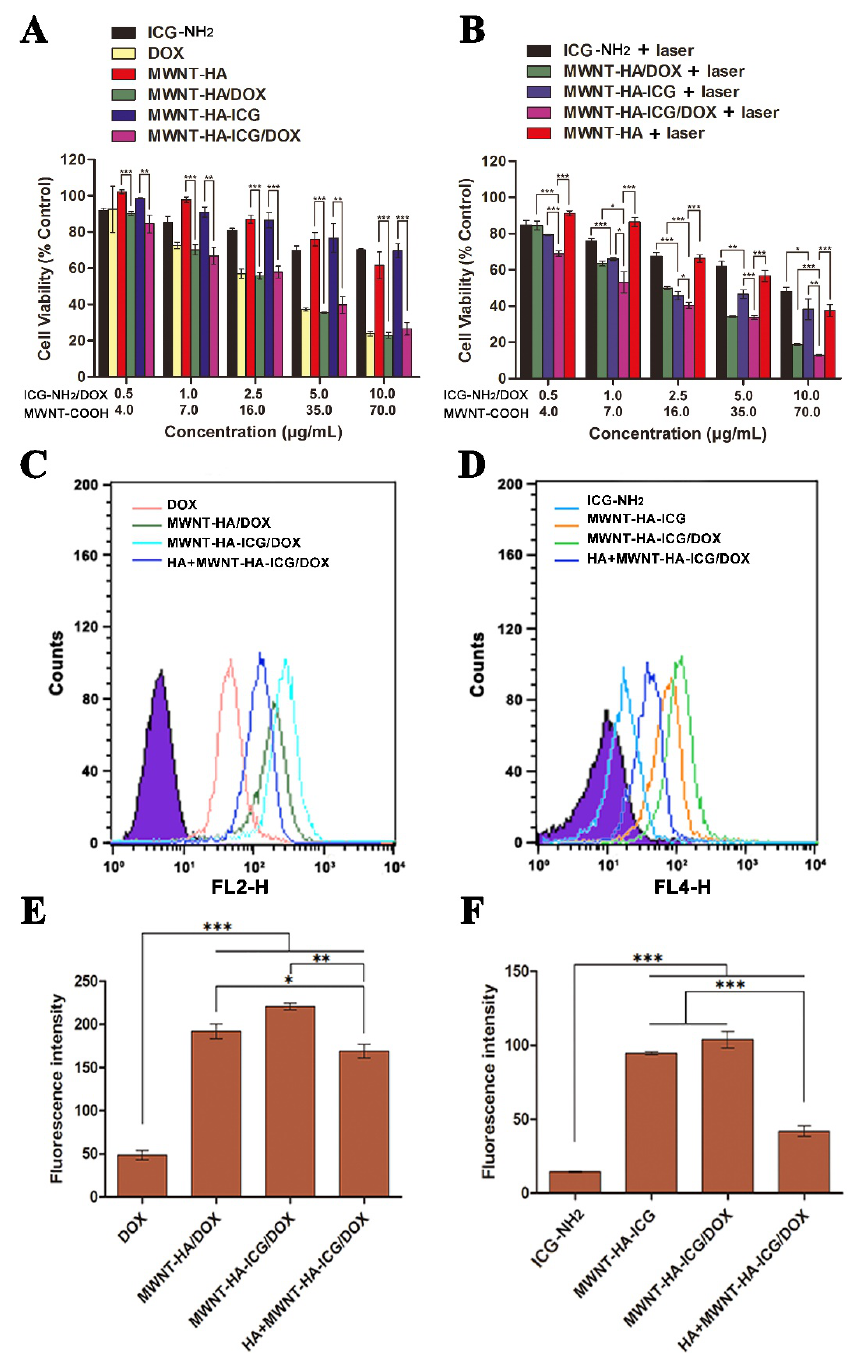
Figure 4. Cell viabilities of MCF-7 cells treated with different formulations at a series of concentra- tions of ICG-NH 2 /DOX and MWNT-COOH for 48 h ( A ) without laser irradiation and ( B ) with laser irradiation (ICG-NH 2 /DOX means ICG-NH 2 and/or DOX). Flow cytometric profiles and fluores- cence intensities of different formulations of ( C , E ) 10 µ g/mL DOX, ( D , F ) 10 µ g/mL ICG-NH 2 at 4 h after treatment. Data were expressed as mean ± S.D. ( n = 3). * p < 0.05, ** p < 0.01, and *** p <